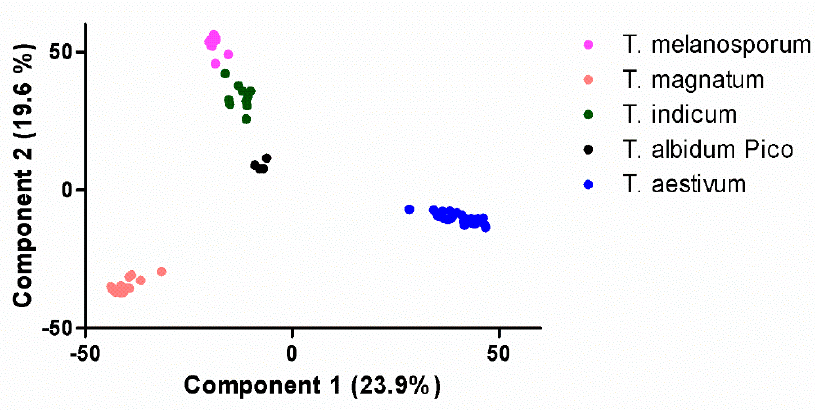
Figure 2. Principal component analysis (PCA) sample projection of the first two components for truffle species. The PCA was performed on 2715 proteins that were identified in all samples.